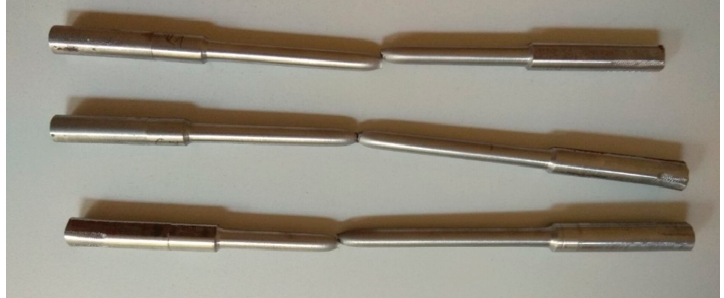
Figure 2. Failure mode of the tensile samples.